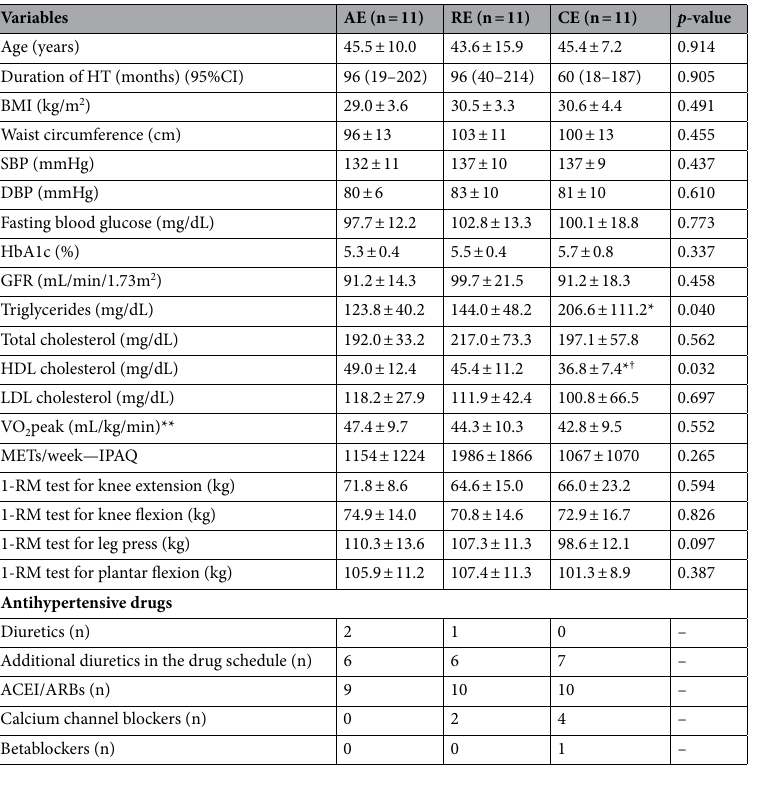
Table 1. Characteristics of participants undergoing three different exercise interventions. Values are expressed as mean ± standard deviation. Duration of hypertension is expressed as median (95% CI). AE: aerobic exercise session; RE: resistance exercise session; CE: combined exercise session; GFR (glomerular filtration rate) was calculated by The Modification of Diet in Renal Disease (MDRD) Study equation; BMI: body mass index; SBP: systolic blood pressure; DBP: diastolic blood pressure; HbA1c: glycated hemoglobin. **VO 2 peak: peak oxygen consumption predicted by the Bruce protocol; METs: metabolic equivalents; ACEI: angiotensin converting enzyme inhibitors; ARBs: angiotensin II receptor antagonists. ANOVA one-way with Bonferroni post-hoc test. * p < 0.05 versus AE. † p < 0.05 versus RE.